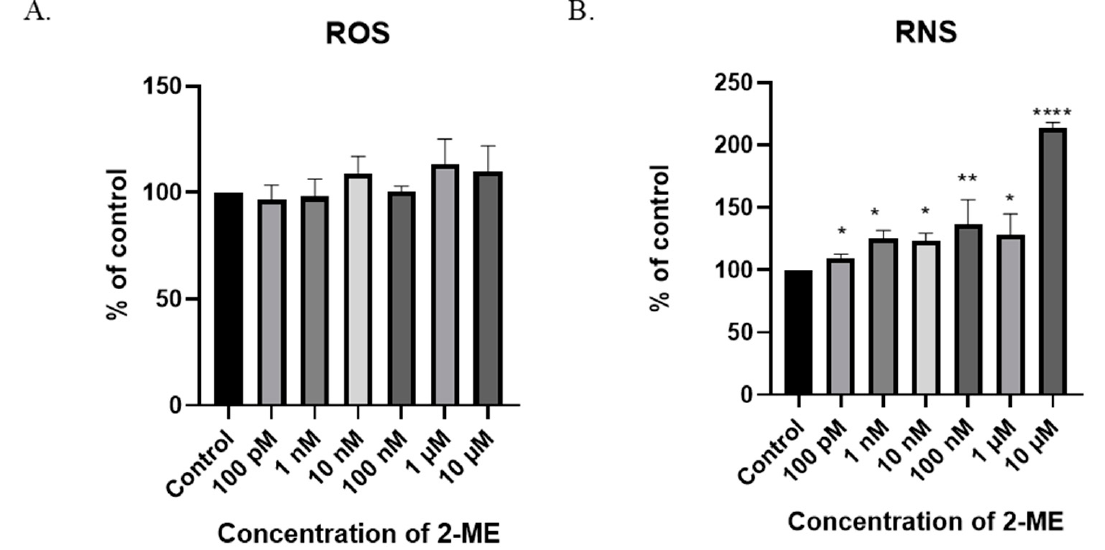
Figure 4. The induction of nitro-oxidative stress by 2-ME. ( A ) No significant change in intracellular ROS levels after treatment of SW1088 cells with 100 pM–10 µ M 2-ME was observed. ( B ) Increase in intracellular RNS levels after treatment of SW1088 cells with 100 pM–10 µ M 2-ME. Values are the mean ± SE of three independent experiments, expressed as % of control cells. The data were analyzed using GraphPad Software, Inc., version 8, USA, by performing one-way ANOVA; * p < 0.05, ** p < 0.01, **** p < 0.0001 versus control. A six-hour treatment of SW1088 glioblastoma cells with 2-ME increased the level of RNS at all the concentrations used: 100 pM—110% ( ± 3.16); 1 nM—125% ( ±